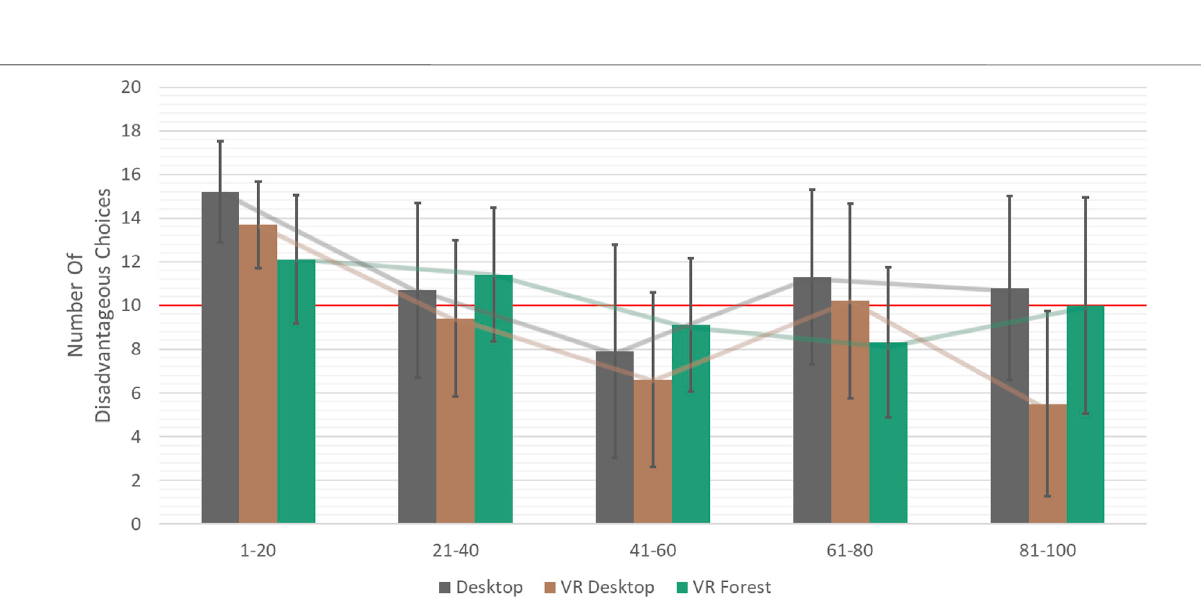
Frontiers in Virtual Reality |